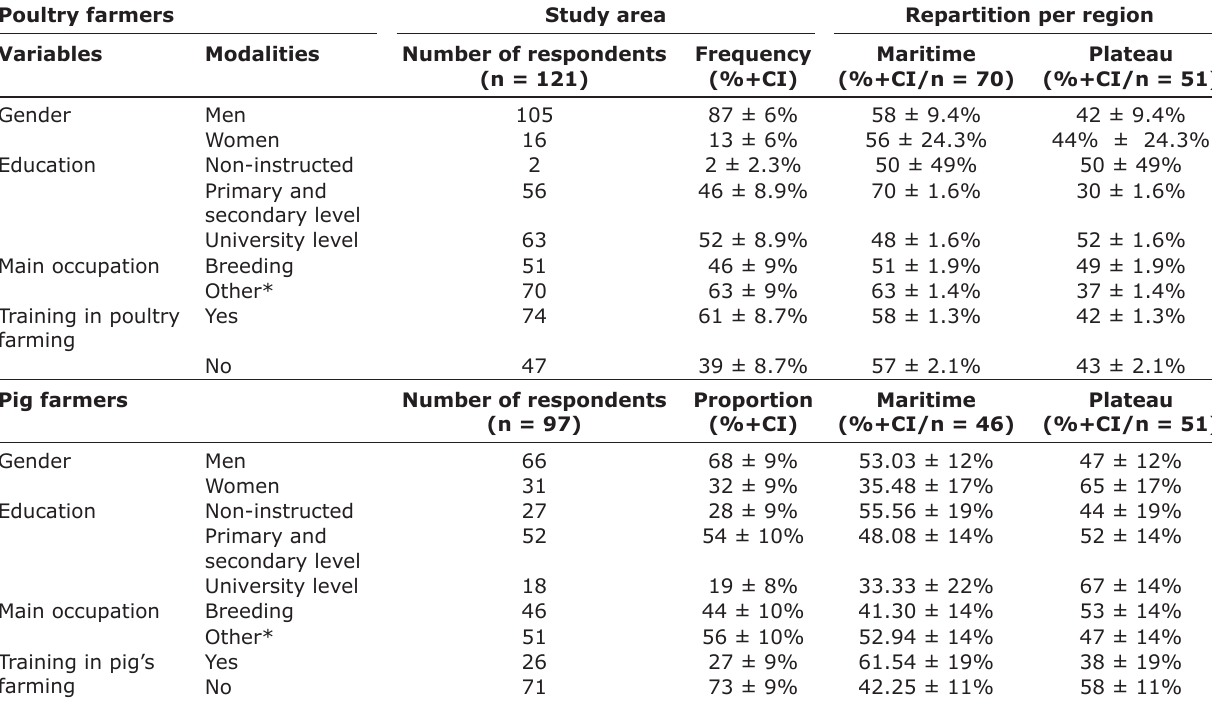
Table-1: Characteristics of surveyed breeders in poultry and pig farms.